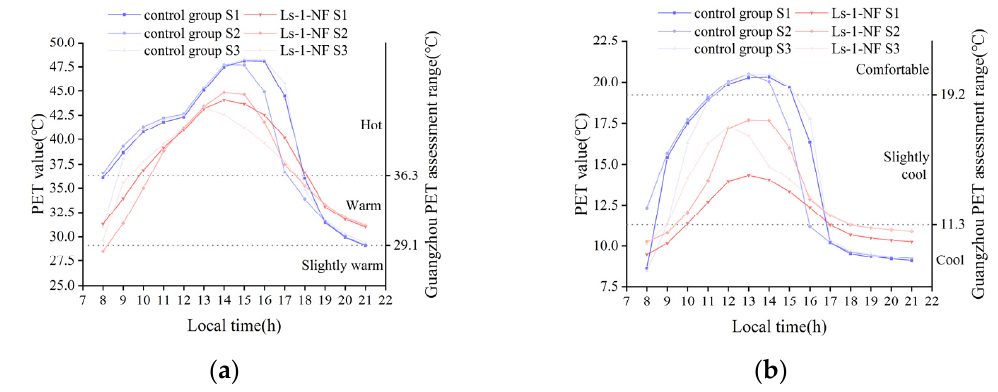
Figure 18. Effects of planting arbors on outdoor thermal comfort in different walking spaces in summer ( a ) and winter ( b ).